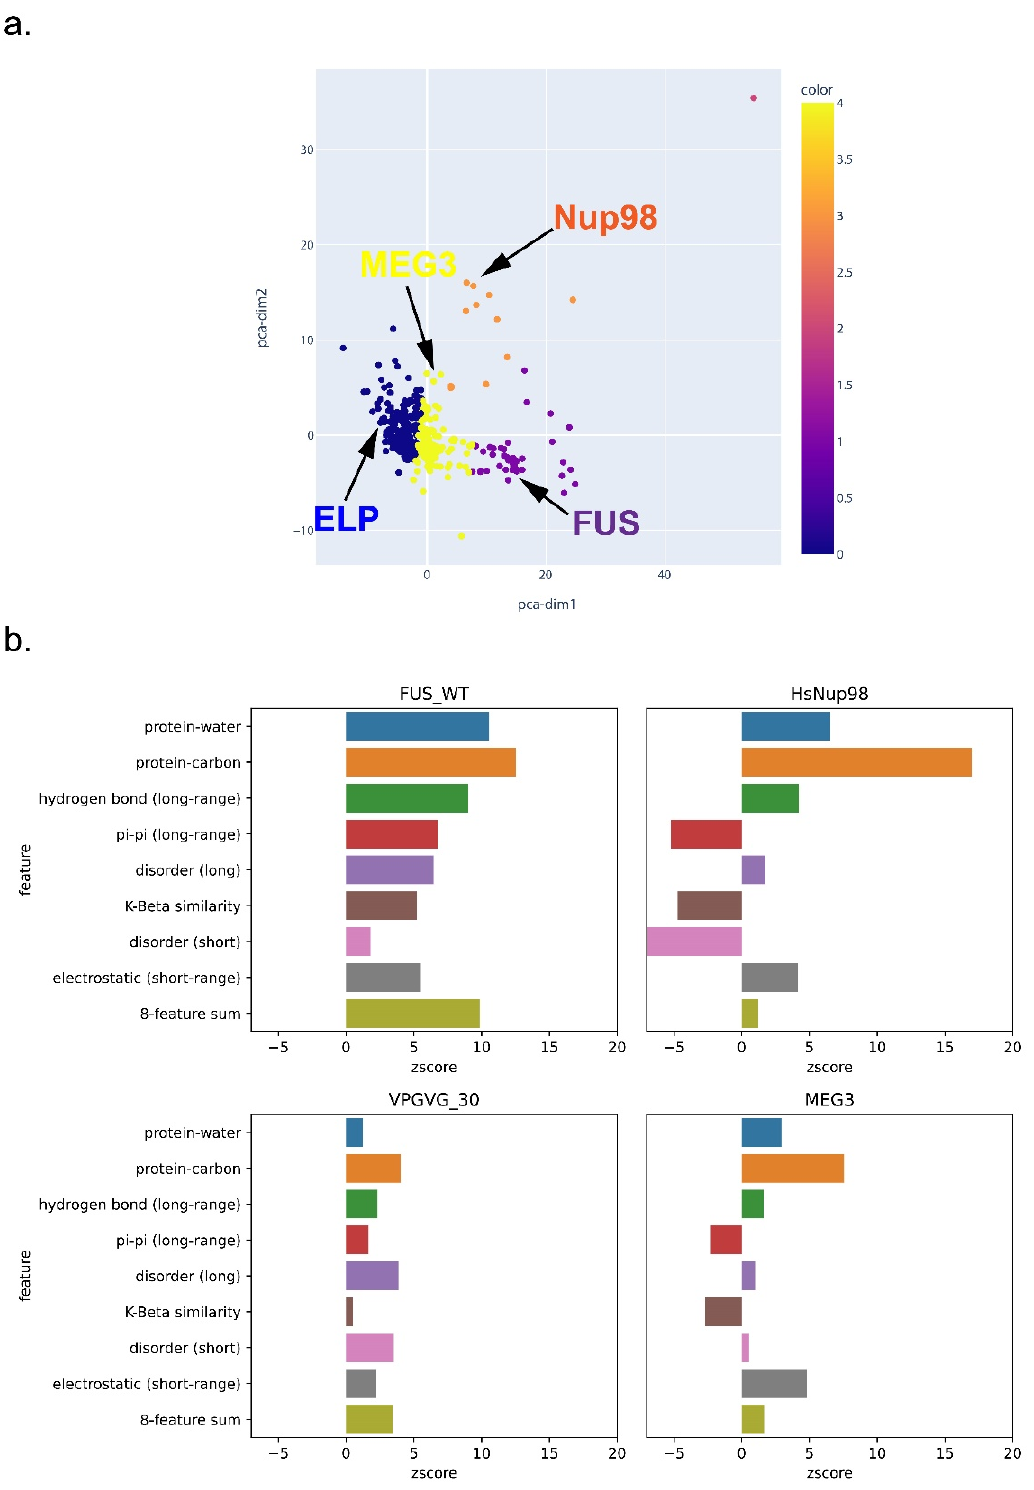
Figure 10. Feature-score-based clustering for PS-positive proteins for the human + PDB model. ( a ) Plot of two abstracted dimensions for clustering based on feature z-scores, showing the separation of different types of phase-separating sequences. ( b ) The score breakdown of four example sequences from four distinct clusters in ( a ): FUS (human), Nup98 (human), elastin-like peptide (ELP, VPGVG_30, 30 repeats of VPGVG) and MEG-3 ( C. elegans